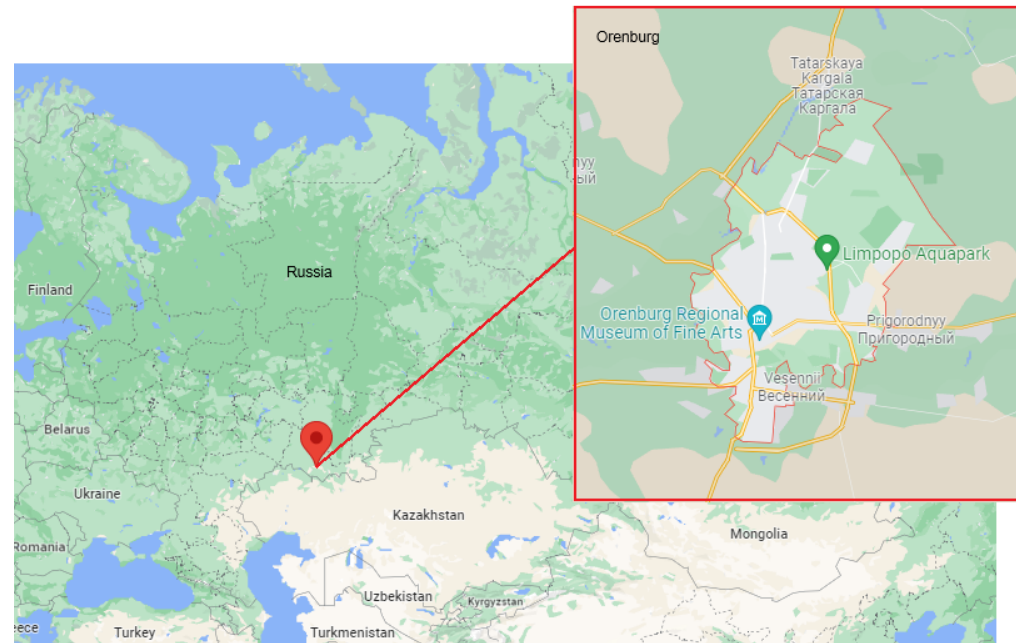
Figure 3. Location of Orenburg within Russia.